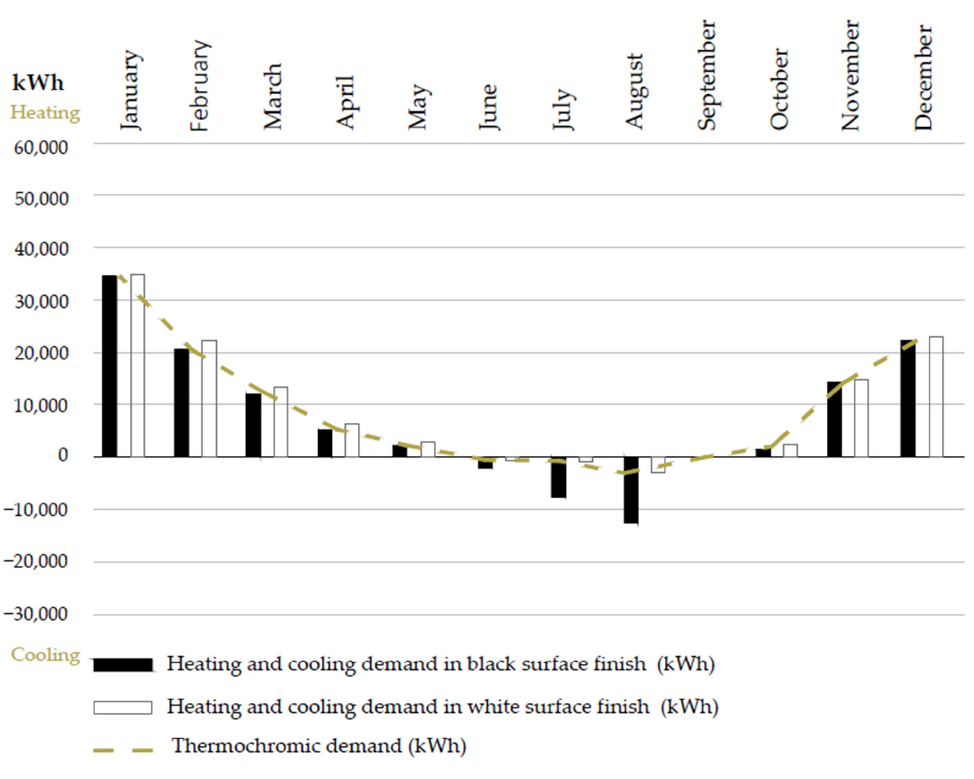
Figure 6. Monthly demand for NBE-79 with black, white, and thermochromic roof surface finishes in the Barcelona CZ.